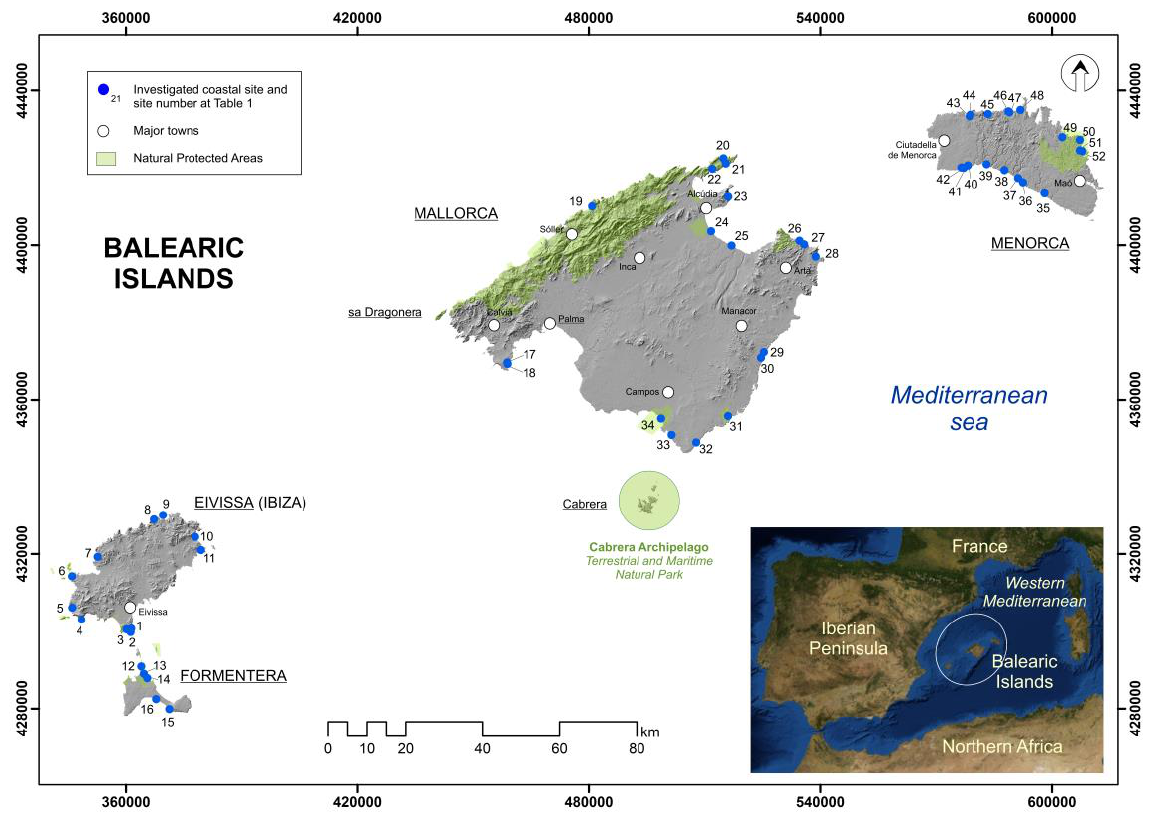
Figure 1. Location map of investigated sites at the Balearic